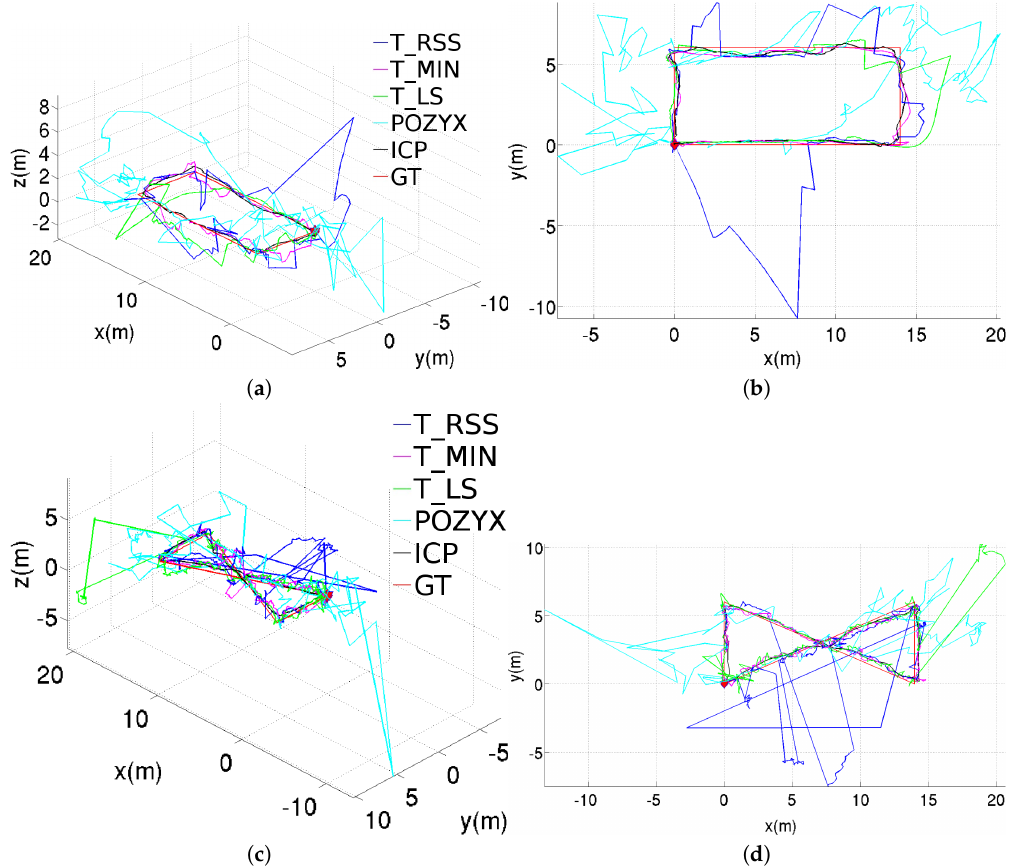
Figure 10. Position estimations provided by the different methods for the two trajectories performed inside the vessel hold, results obtained using both the pre- and post-filtering stages: ( a ) perspective and ( b ) top views for the rectangular trajectory; ( c ) perspective and ( d ) top views for the figure-eight-like